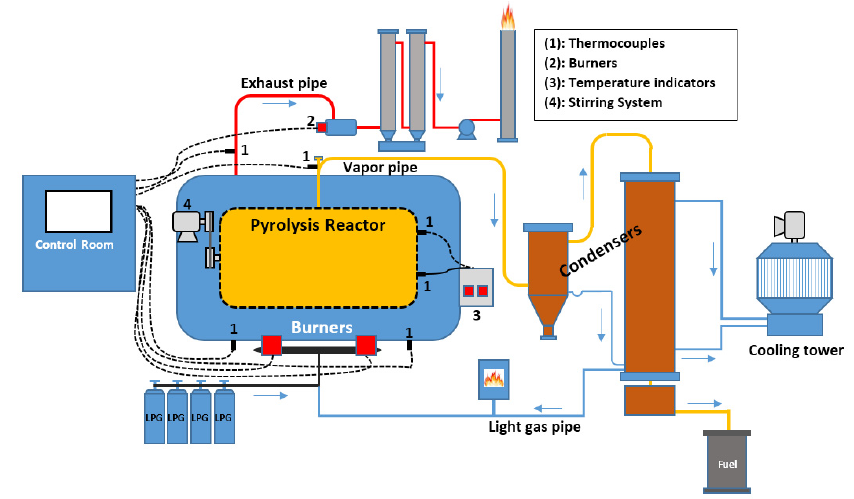
Figure 9. Schematic diagram of the pyrolysis system during the production of waste cooking oil